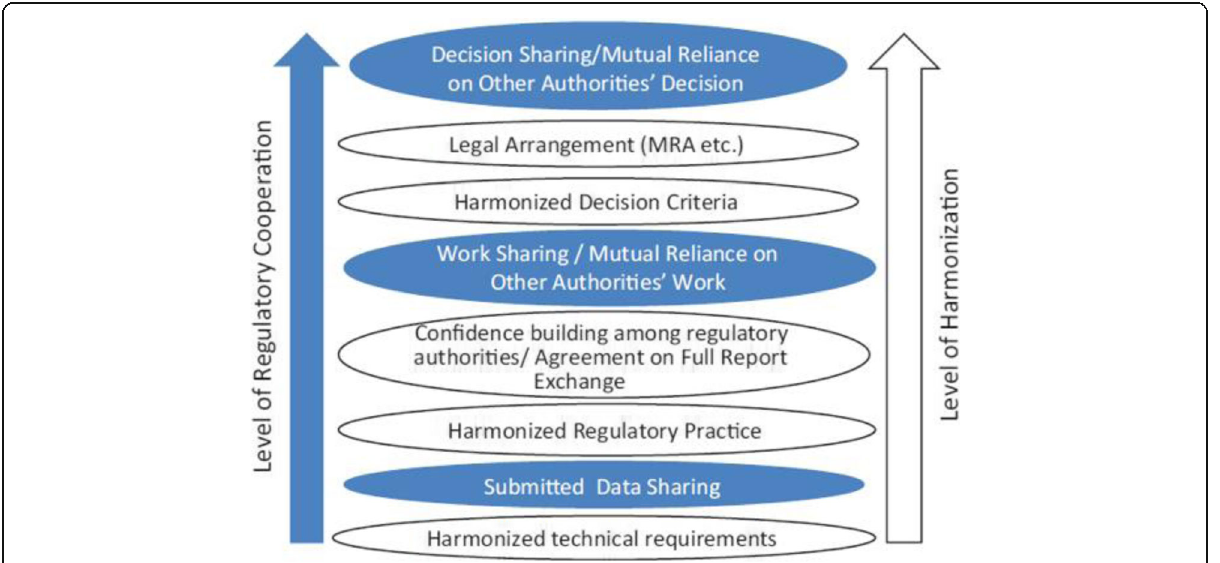
Fig. 1 (Tominaga 2013) Level of harmonization and regulatory cooperation. As the degree of regulatory cooperation advances from sharing of submitted data to work sharing/mutual reliance on other authorities ’ work, and to decision sharing/mutual reliance on other authorities ’ decision, the necessary level of harmonization also advances from that of technical requirements to regulatory practice and to decision criteria. Also necessary are other efforts such as confidence building and legal arrangements among the participating regulatory